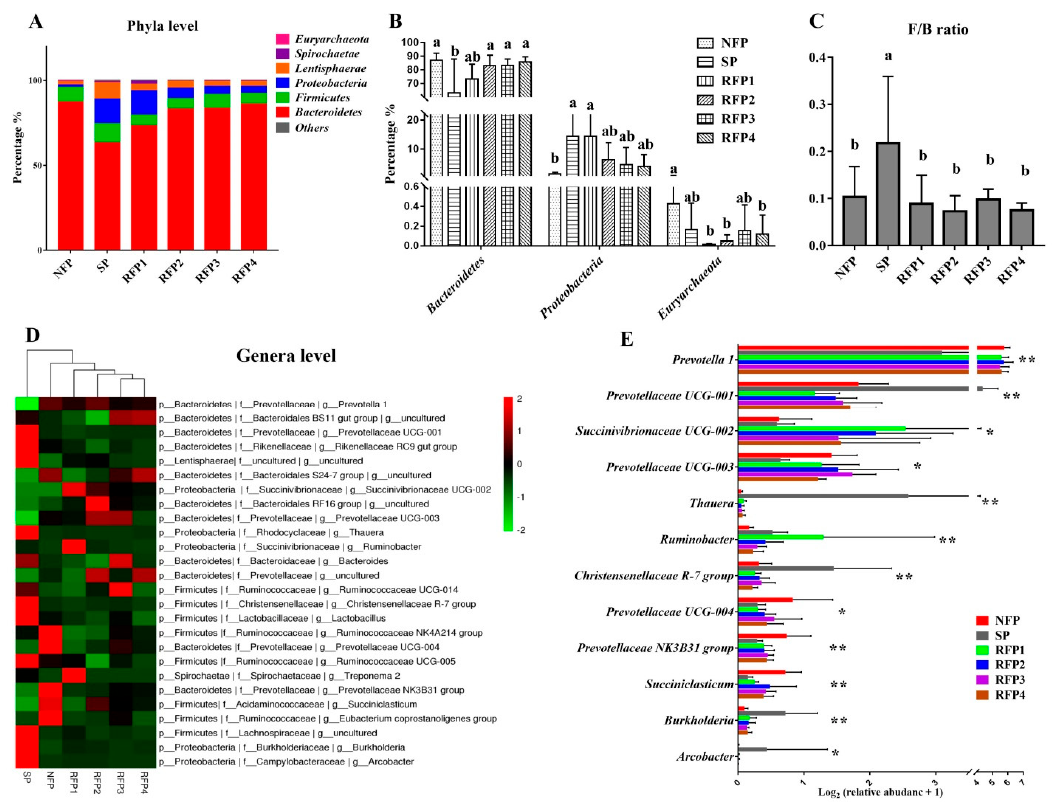
Figure 4. Starvation and prolonged refeeding remodel microflora in the rumen of yaks. ( A ) Rumen microbial community composition at phyla level. ( B ) The significantly changed bacteria at the phyla level. ( C ) The fluctuation of the F/B ratio (the ratio of Firmicutes to Bacteroidetes) through the experimental periods. ( D ) Rumen microbial community composition at genera level. ( E ) The significantly changed bacteria at the genera level. In the heatmap, the X-axis represents different groups, and the Y-axis represents different bacterial genus. The abundances of the bacterial genus are represented by the color intensity. Different small letter superscripts represent significantly different ( p < 0.05). * represents p < 0.05, ** represents p < 0.01.